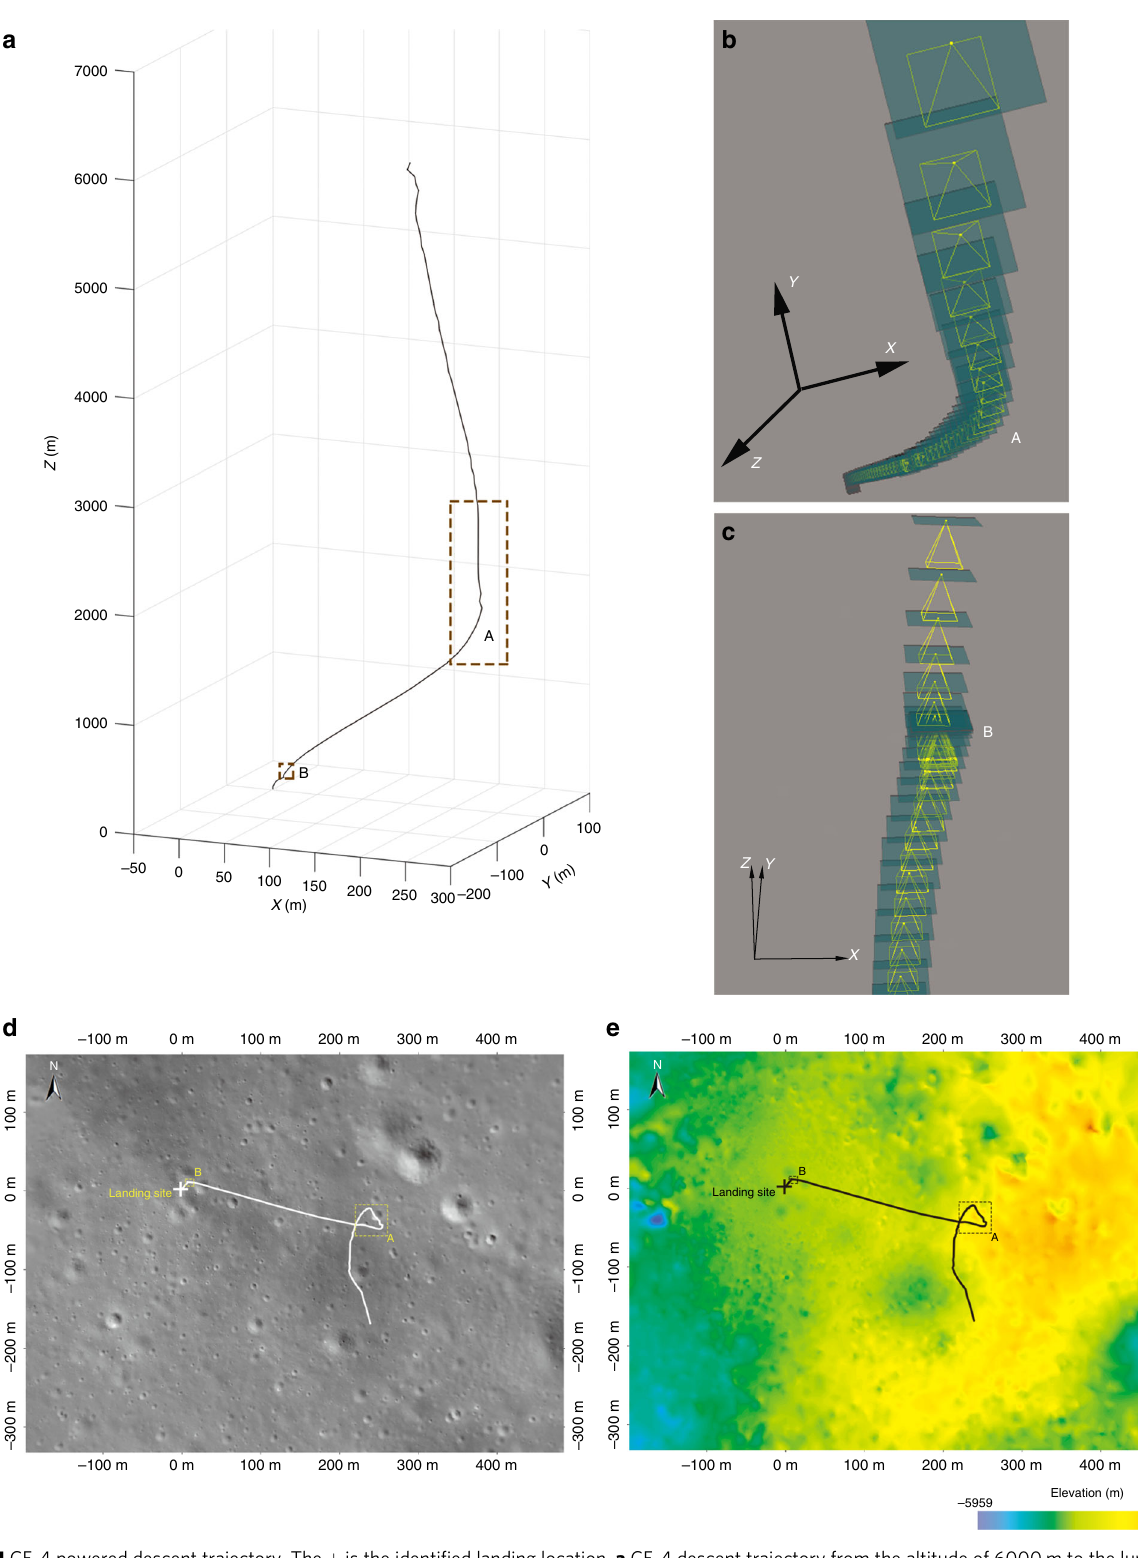
Fig. 1 CE-4 powered descent trajectory. The + is the identi fi ed landing location. a CE-4 descent trajectory from the altitude of 6000 m to the lunar surface; b , c are zoomed images of the descent trajectories of A and B, respectively. The green box represents the position of the LCAM focal plane, and the yellow cone represents the fi eld of view of the LCAM. d The solid white line is the projection of the descent trajectory on the LCAM DOM. e The solid black line is the projection of the descent trajectory on the LCAM DEM. The coordinate system in this fi gure is the tangent plane coordinate system of the landing site. This system uses the location of the landing site as the coordinate origin, with its X and Y axes pointing towards the geographical east and the north of the landing site, respectively. The Z-axis, X-axis, and Y-axis form a right-hand system, with the Z-axis pointing to the zenith direction of the landing